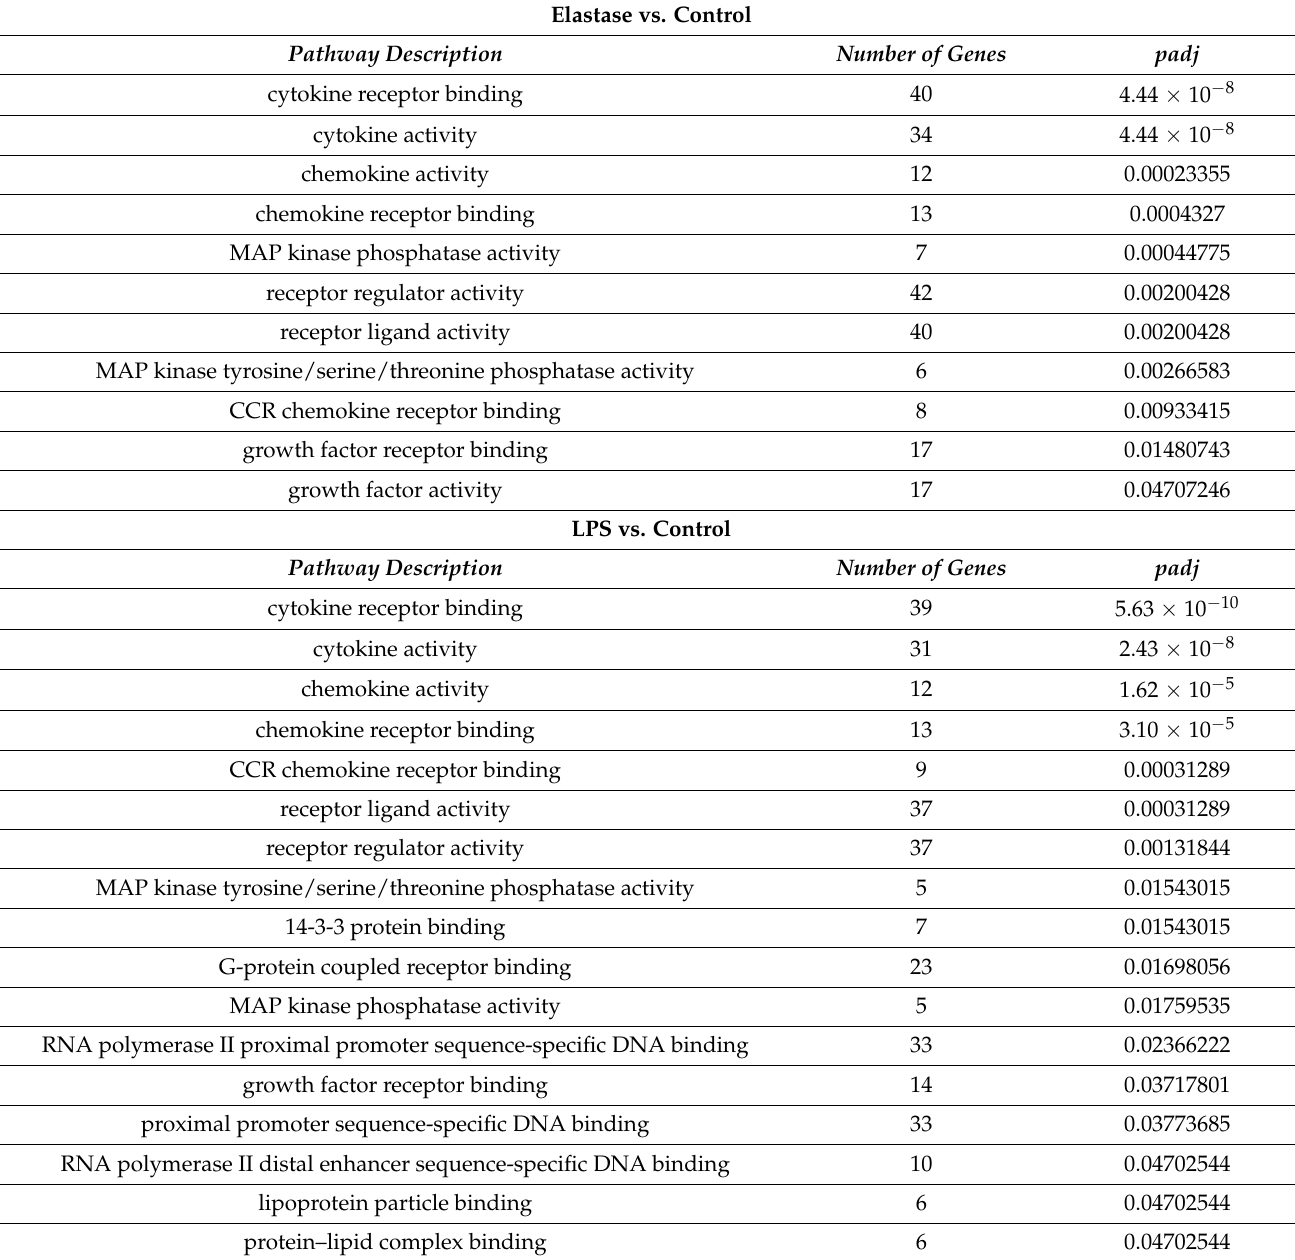
Table 1. Gene Ontogeny Molecular Function Enrichment Pathways. Elastase vs.